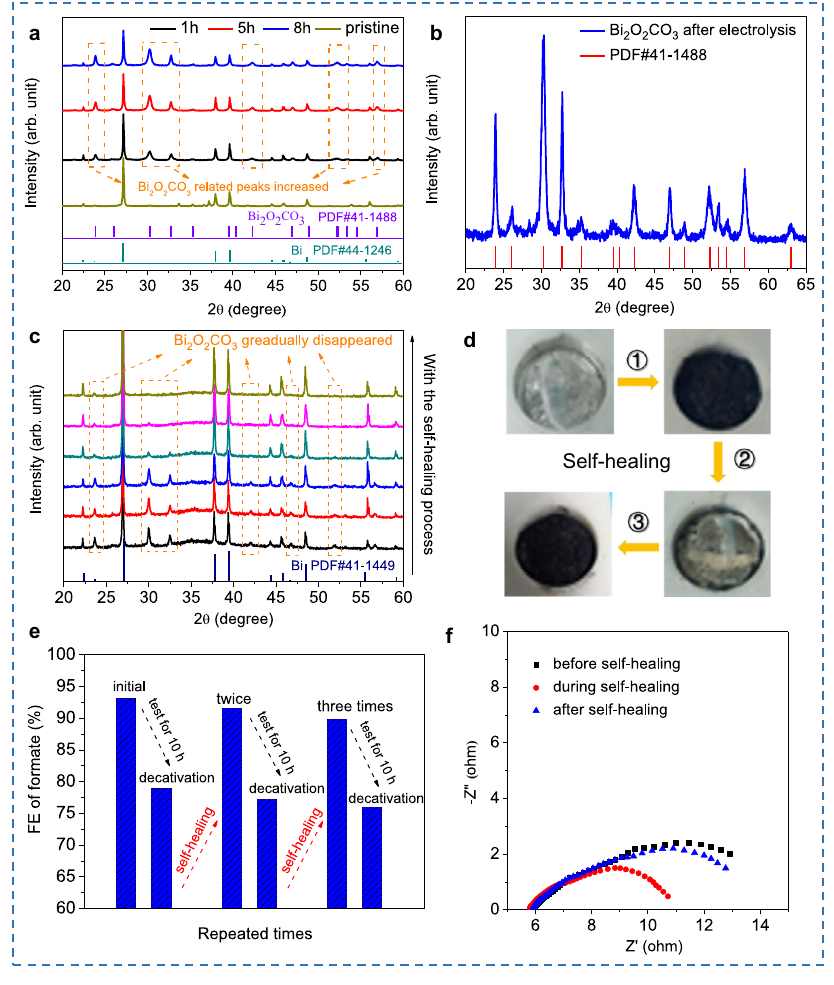
Fig.5|Structuralandelectrochemicaldatapresentationrelatedtoself-healing process. a XRD patterns for bismuth catalyst loaded on LM surface during elec- trocatalytic CO 2 RR process. b XRD patterns for Bi 2 O 2 CO 3 directly loaded on LM surface after 4h of reaction. c In situ XRD patterns of Bi catalysts phase